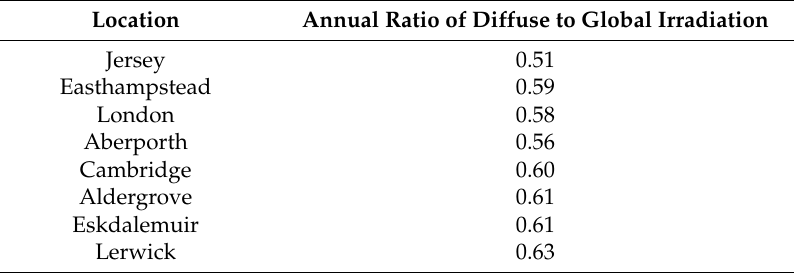
Table 1. Annual diffuse ratio for UK